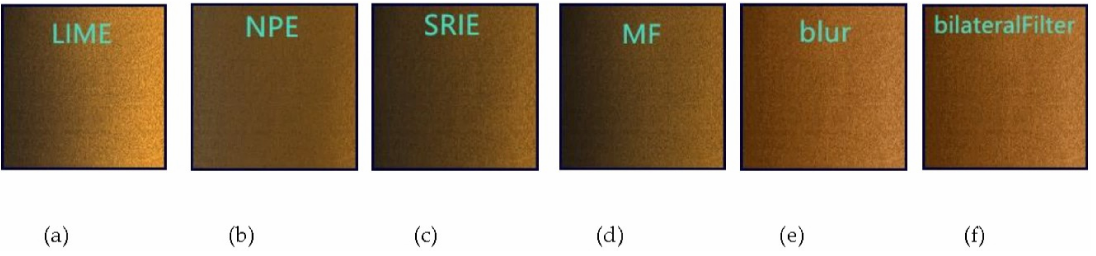
Figure 13. Local enlargement of the second kind of enhanced image ( a ) LIME, ( b ) NPE, ( c ) SRIE, ( d ) MF, and our method with ( e ) mean filtering, and ( f ) bilateral